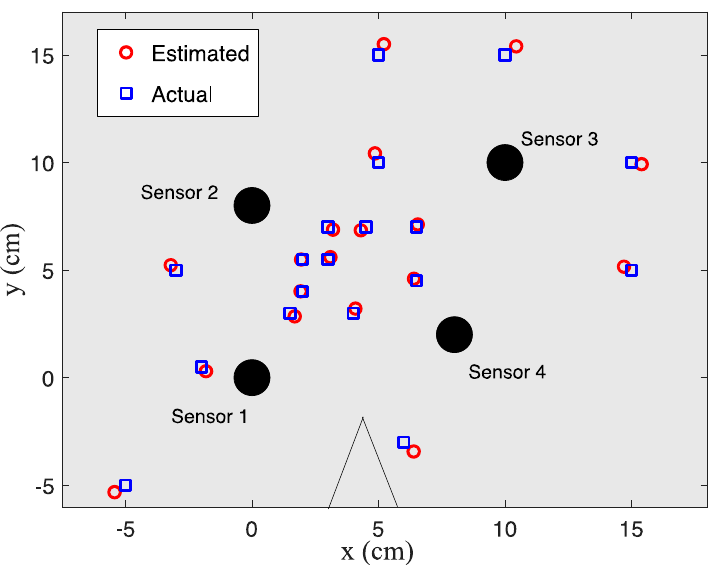
Figure 7. Location of the different AE hits emitted by the 18 pencil lead breaks performed on the aluminum surface on the basis of the abovementioned